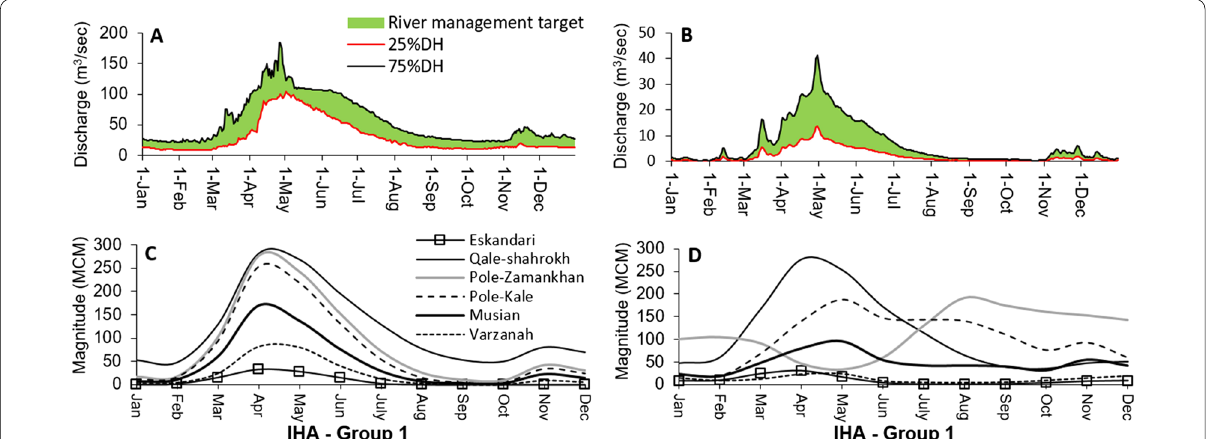
Fig. 3 A River management targets for Qale-Shahrokh station; B river management targets for Varzanah station; C magnitude of monthly natural flow regime along the Zayandeh-Rud River; D post-dam flow